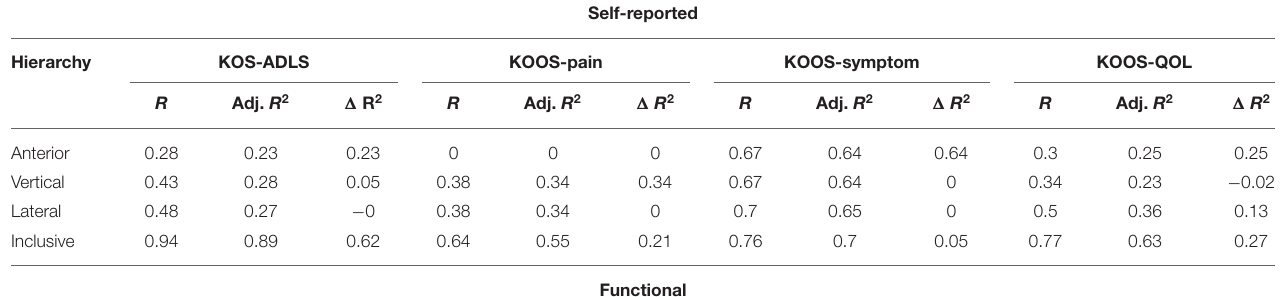
TABLE 4 | Hierarchical linear regressions result for self-reported survey